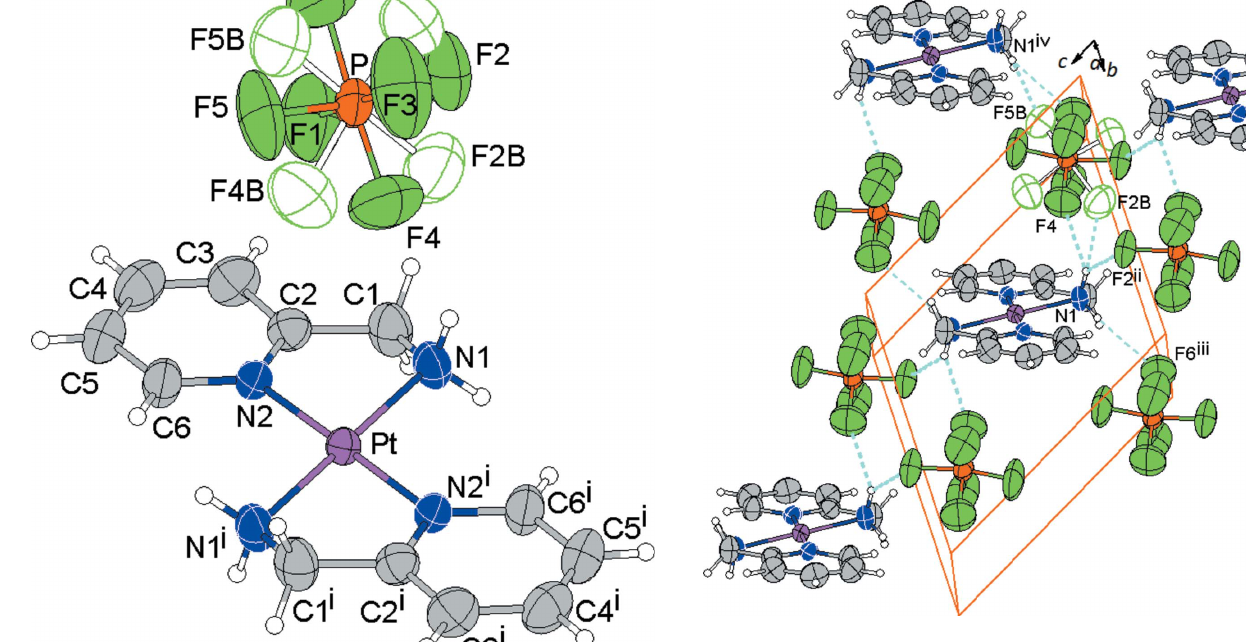
Figure 3 Hydrogen bonds between the amino groups of the 2-(aminometh- yl)pyridine ligands of the platinum complex molecules and fluorine atoms of the hexafluoridophosphate anions, represented by light-blue dashed lines. Orange solid lines indicate the unit cell. The minor disordered parts of the PF 6 anions were omitted for clarify except for one site [symmetry codes: (ii) (cid:2) x , 1 (cid:2) y , (cid:2) z ; (iii) x , 1 + y , z ; (iv) x , (cid:2) 1 + y , z ].